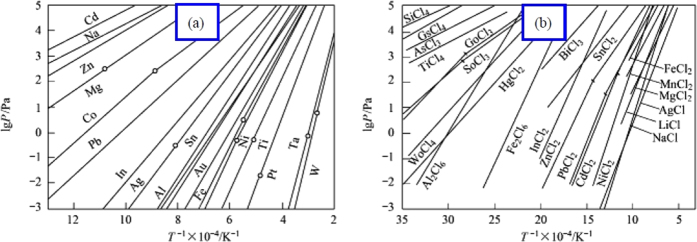
Vapour pressures of (a) heavy metals and (b) their chlorides.